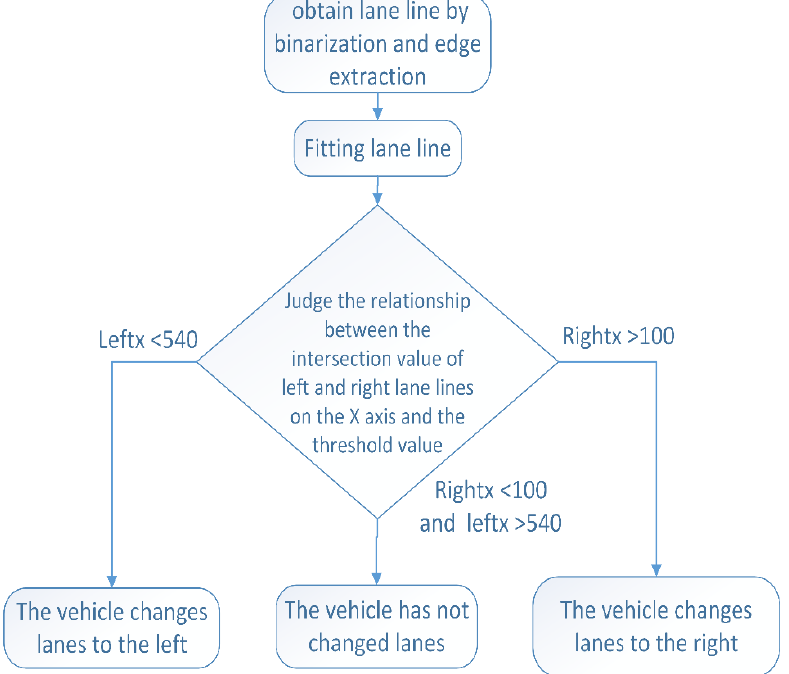
Figure 7. Flow chart of monocular camera lane change judgment.